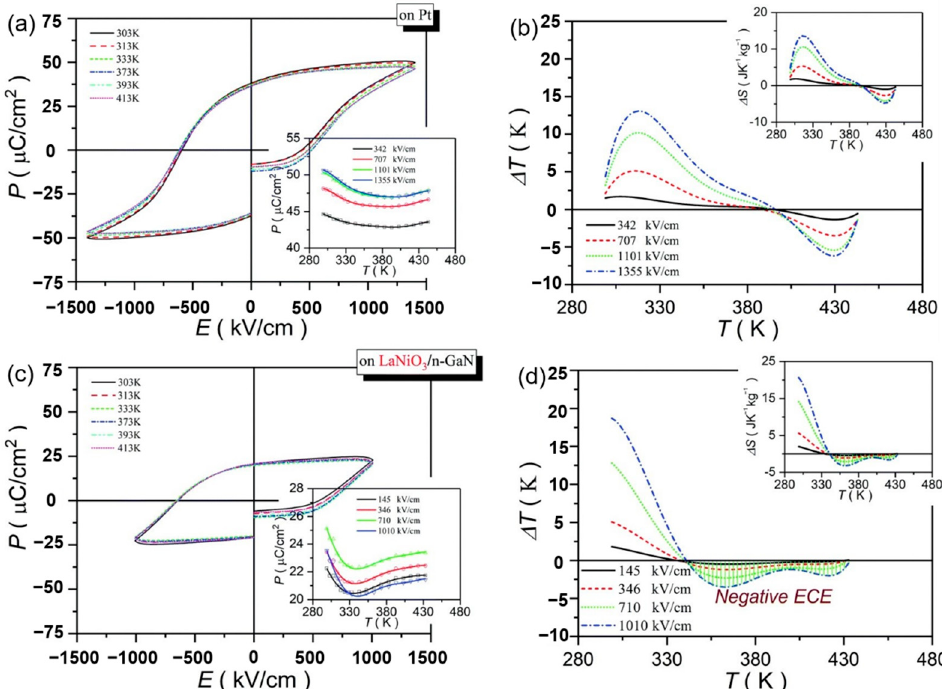
Figure 28. P-E loops and the corresponding Δ T ( T ) of the PBLZ thin films at selected temperatures at 10 kHz. ( a , b ) on Pt substrate. ( c , d ) on LaNiO 3 /n-GaN substrate. Insets in ( a , c ): P ( T ) at selected electric fields . Insets in ( b , d ): Δ S ( T ) at selected electric fields. Reprinted with permission from [106].Copyright 2019 The Royal Society of Chemistry.